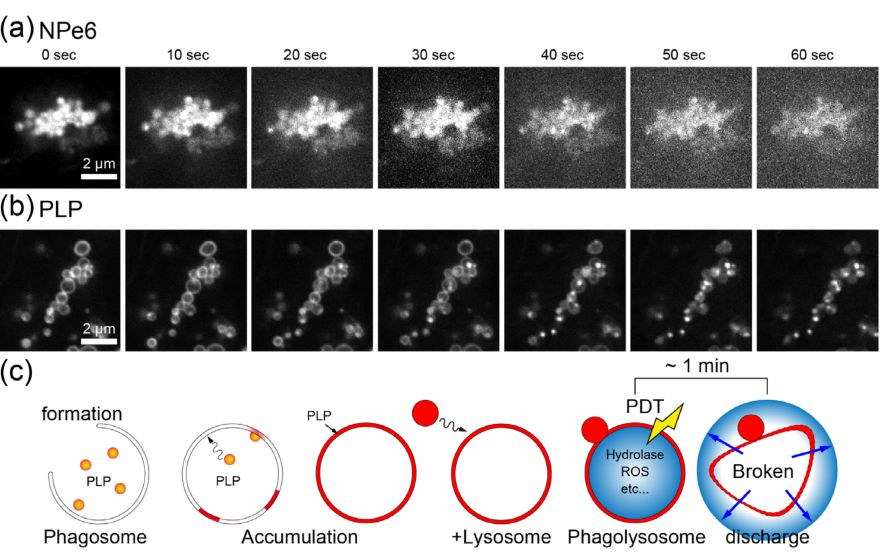
Figure 8. Confocal fluorescence observation images of ( a ) NPe6 and ( b ) PLP during 1 min of irradiation with light of 640 nm wavelength and 439 mW/cm 2 . ( c ) Schematic diagram of PLP uptake and destruction of phagosome membrane. In ( a ), the contrast has been